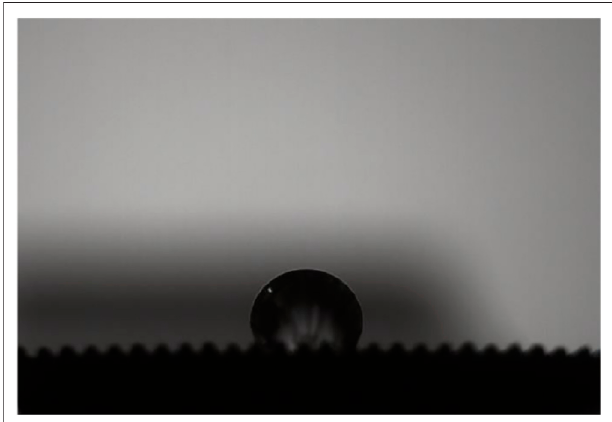
FIGURE1 | The jagged microstructure in surface wettability experiment.